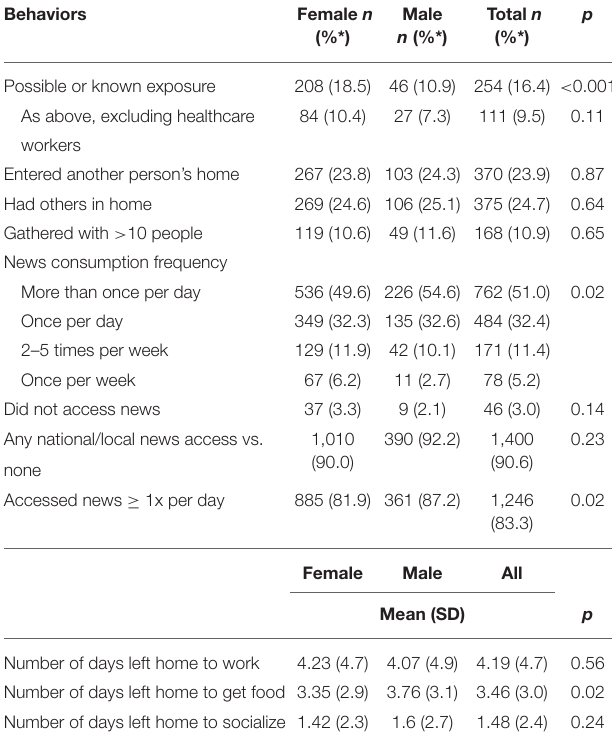
TABLE 1 | Respondent characteristics by binary gender identity. TABLE 2 | Respondent behaviors in the 2-weeks prior to SARS-CoV-2 viral test.